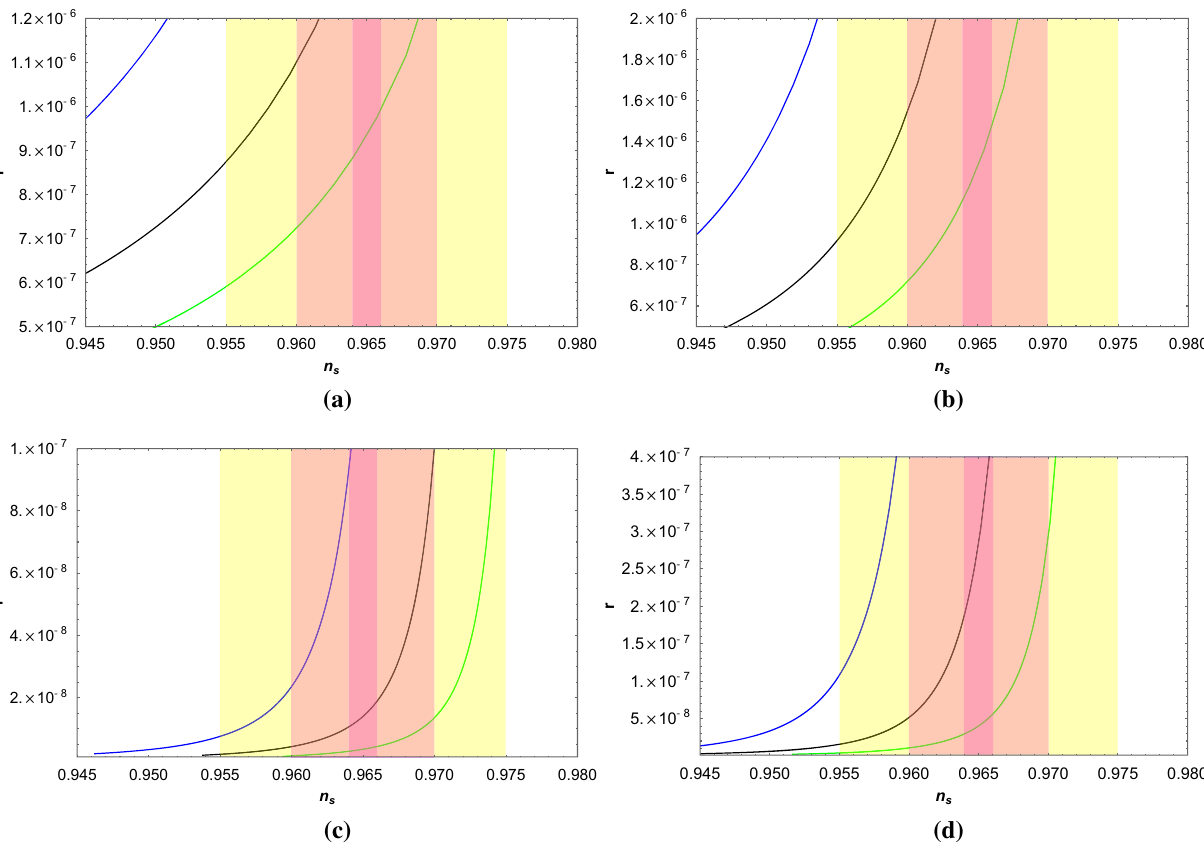
Fig. 4 Plots of r and n s as a function ρ 0 for fixed values of V 0 = 10 8 GeV. In a n = 1 , q = 4 and m = 10 − 6 , b n = 2 , q = 4 and m = 10 − 3 , c n = 3 , q = 4 and m = 10 − 3 and in d n = 4 , q = 4 and m = 10 − 3 . The blue line corresponds to N e = 55, the black line corresponds to N e = 65, the green line corresponds to N e = 75 .